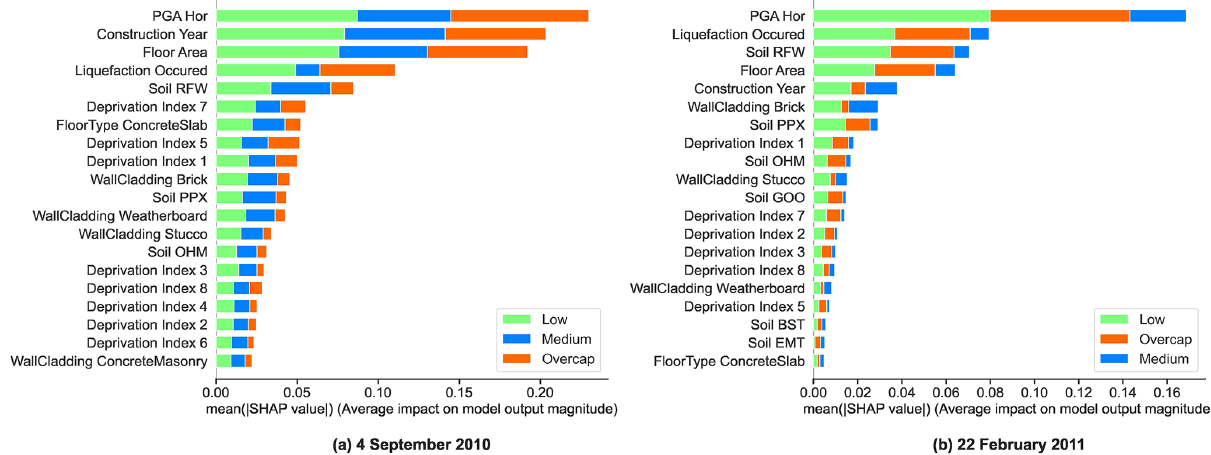
Figure 13. SHAP feature importance for the random forest model: (a) 4 September 2010 and (b) 22 February